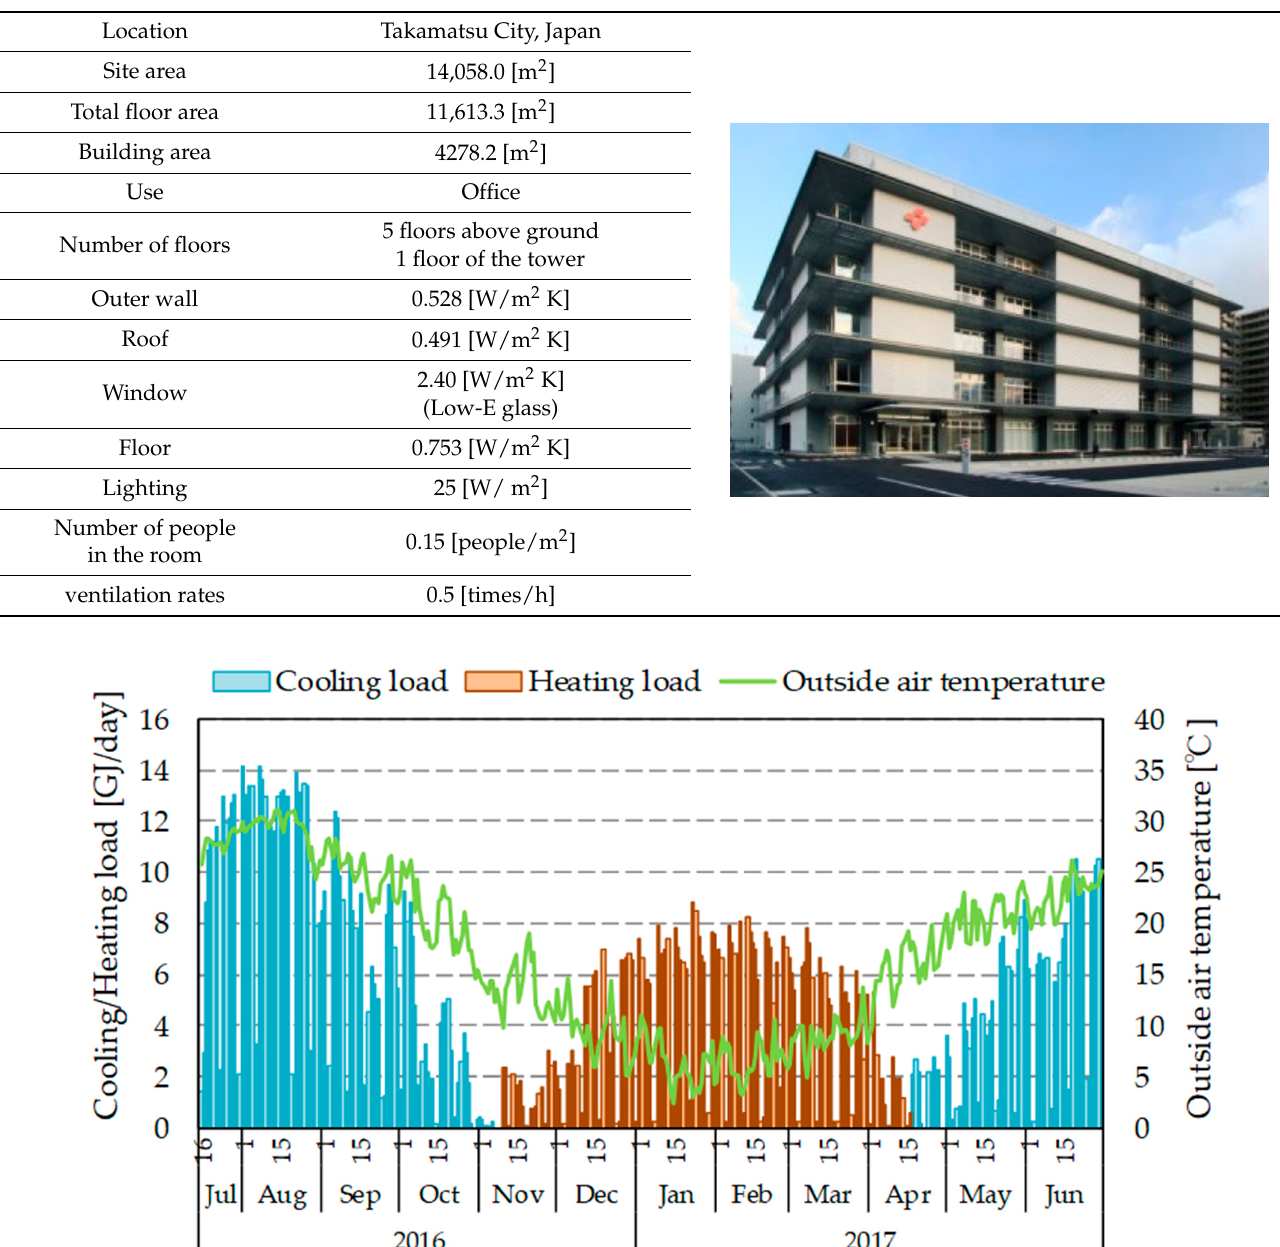
room of the target building. Figure 6a shows the AHU air inlet temperature in